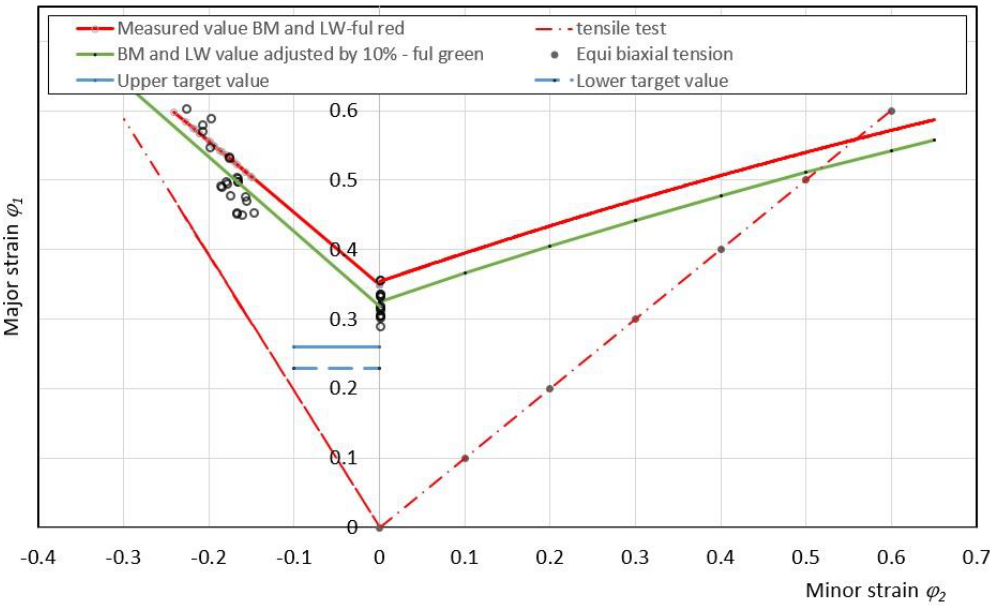
Figure 15. Forming limit diagram of the AISI 304 and AISI 304LW materials. Based on the major and the minor strain values measured in the yellow zone, the left parts of the FLC were constructed for the base material AISI 430 BM and for the laser- welded material AISI 430 LW Figure 16. The solid red line indicates the upper limit curves of the limit strains and the green solid line the curves reduced by 10% for the base material AISI 430 BM. The solid red line indicates the upper limit values of the FLCs and the green line the curves reduced by 10%. The upper target strain φ 1 value required to convert the blank into the finished surface part of the catalytic converter is indicated by a solid blue line for φ 2 from − 0.1 to 0 in the FLD, and the lower target strain φ 1 value for the φ 2 from − 0.1 to 0 is indicated by a dashed blue line. Figure 16 shows that the target value of strain required for the production of the catalytic converter from the base AISI 430 BM material is exactly the target value below the FLC reduced by 10% for AISI 304 BM. In this case, too, it must be stated that the risk of excessive thinning of the wall is significant, even for small deviations in production conditions.